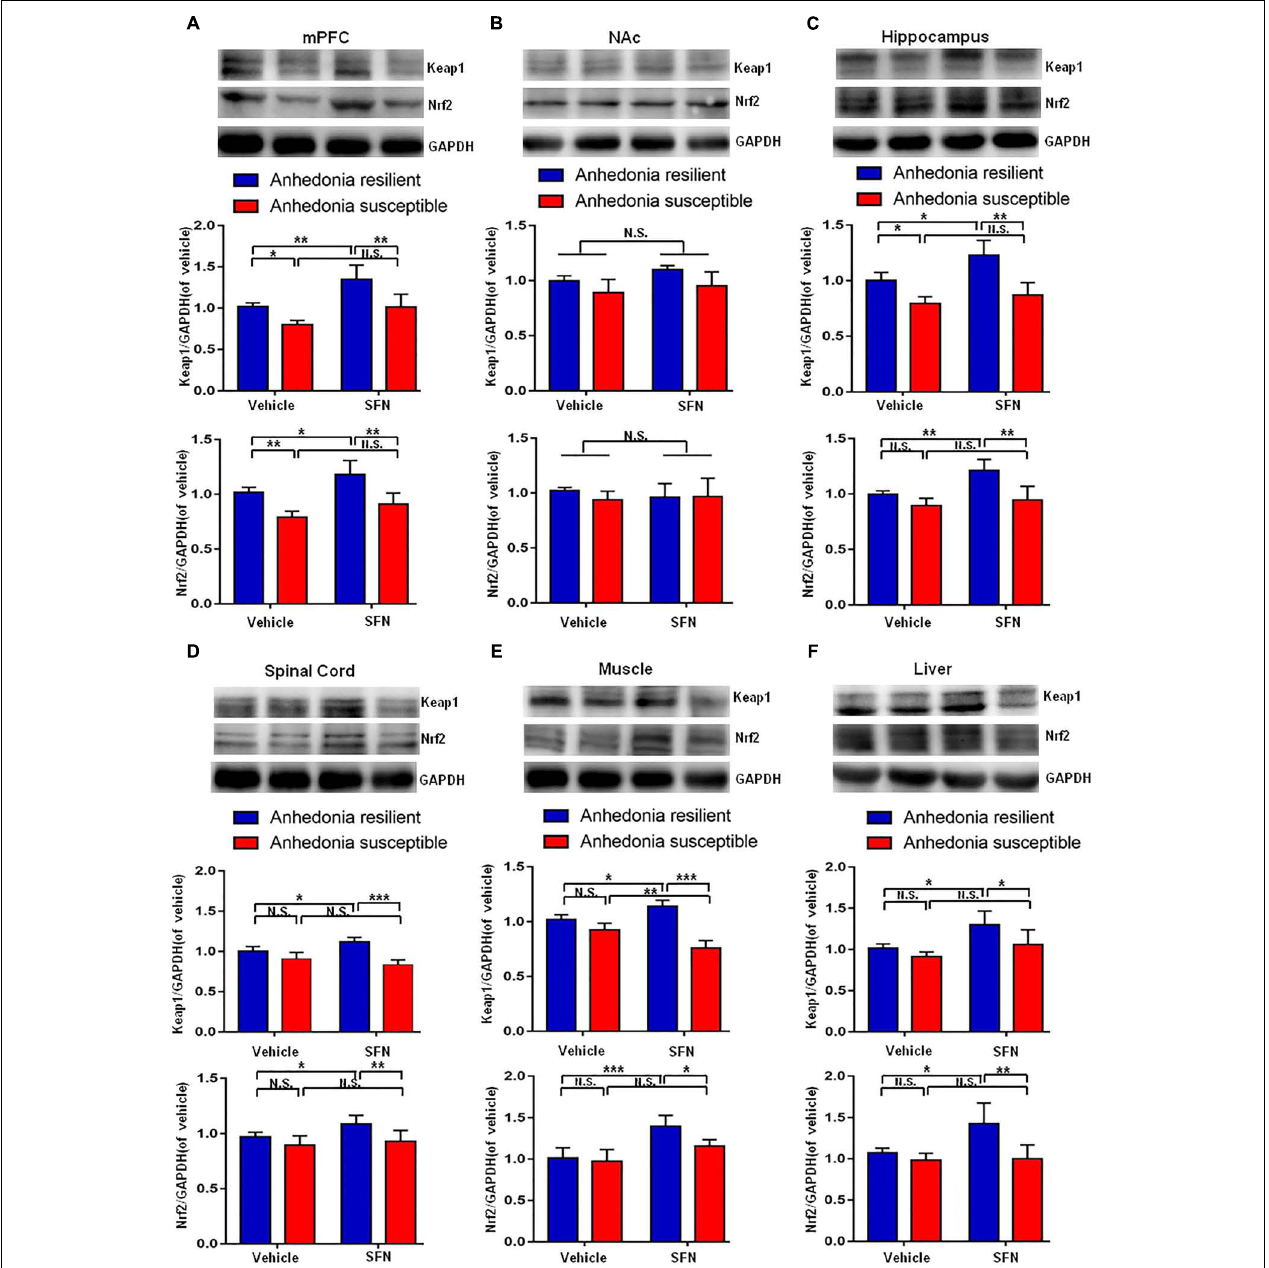
FIGURE 6 | Effects of SFN treatment before SNI surgery on Keap1-Nrf2 signaling in selected tissues. (A) Keap1 [SFN: F ( 1 , 16 ) = 25.1 , P = 0.001; Phenotype: F